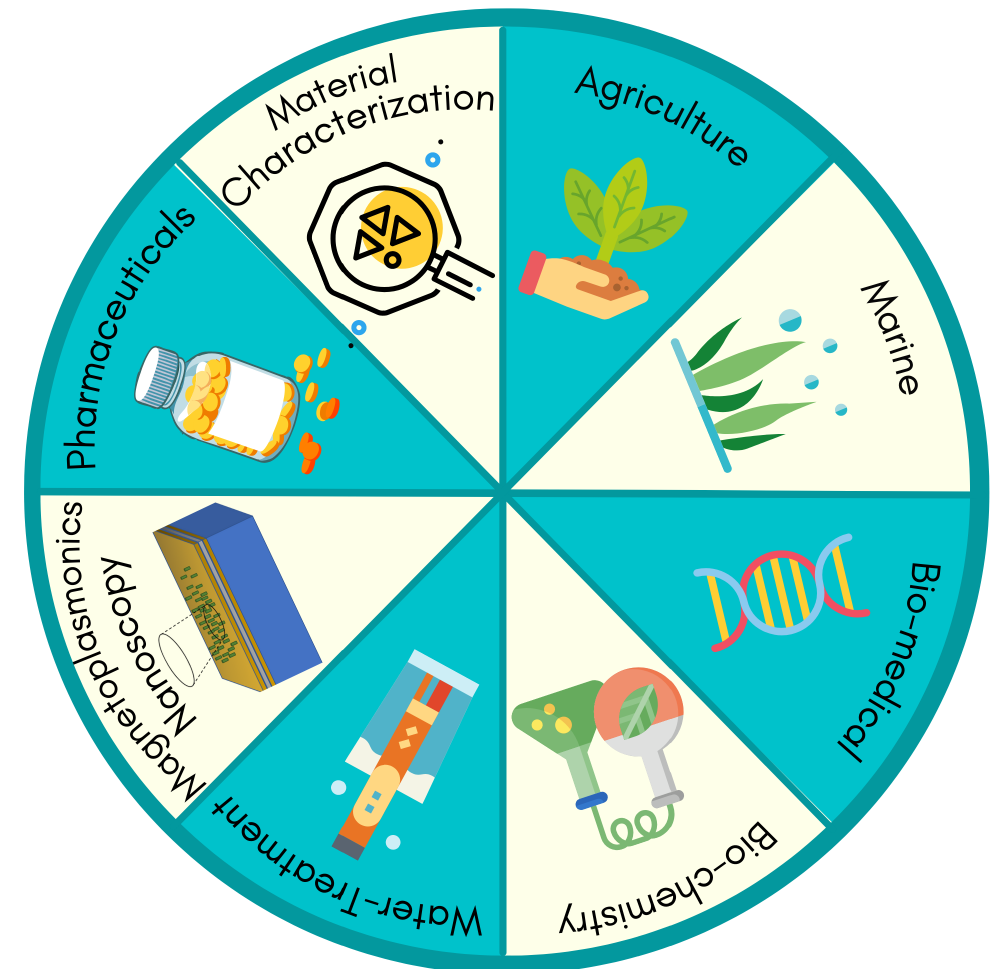
Figure 10. Potential applications of MO-SPR sensors in industry (e.g., nanostructure